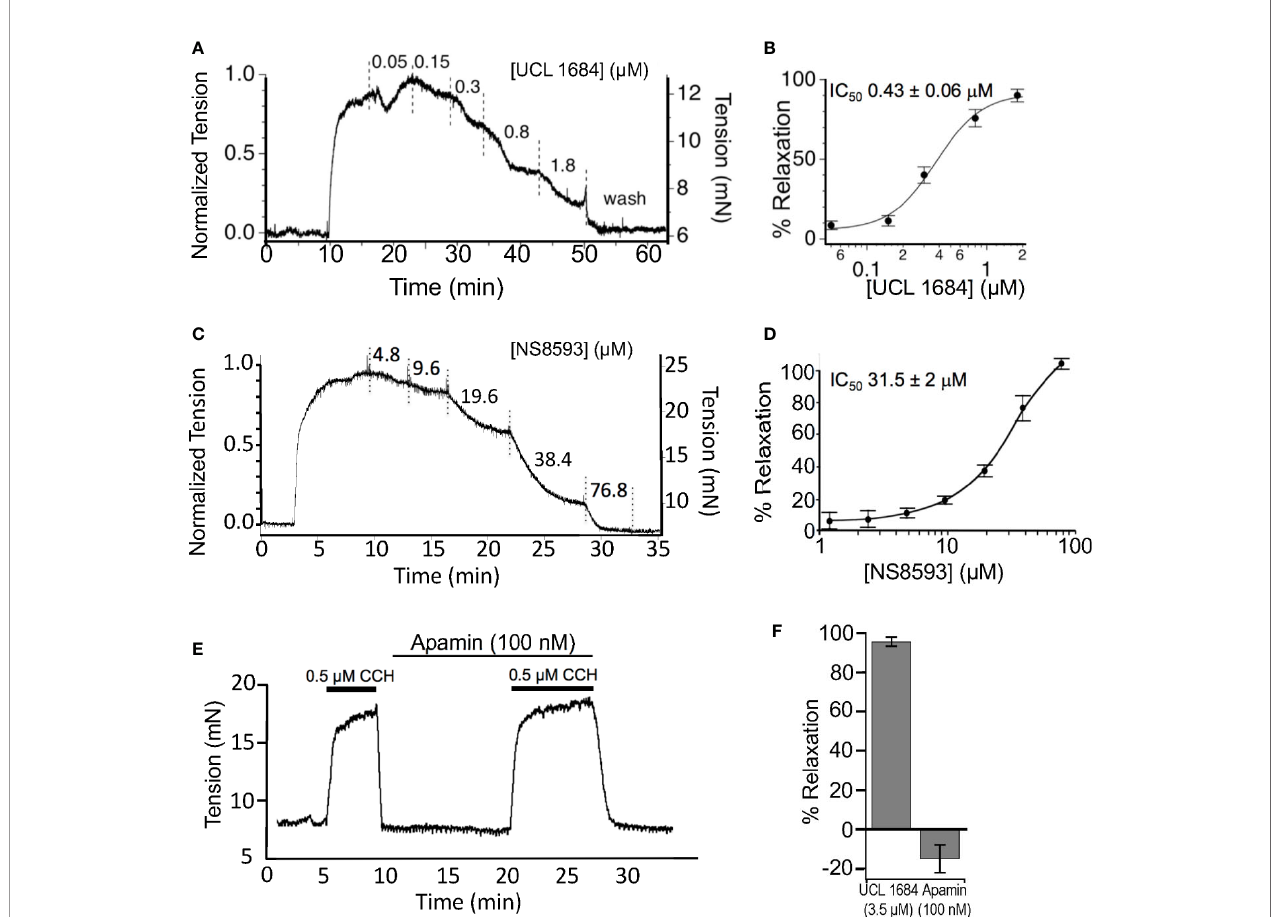
FIGURE 3 | UCL 1684 relaxes cholinergic evoked airway smooth muscle contractions. (A) Example isometric tension measurement of mouse trachea. The trachea was precontracted with 0.5 m M carbachol and cumulative increasing concentrations of UCL 1684 was applied to the bath at approximately 5-min intervals (or until tensions approached steady state levels). (B) Average response from N = 5 tracheas. The IC 50 was estimated to be 0.43 ± 0.06 m M, slope 1.7 ± 0.32 using a Hill function to the average response. (C) An example cumulative dose-relaxation response to increasing concentrations of NS8593. (D) Average response from N = 4 – 8 tracheas (depending on dose). The IC 50 was estimated to be 31.5 ± 2.0 m M, slope 1.3 ± 0.22 using a Hill function to the average response. (E) Example contraction in response to 0.5 m M carbachol, without and with wash-in of 100 nM of Apamin. (F) Summary comparisons of relaxation to 0.5 m M carbachol using single doses of 3.5 m M UCL 1684 (95.4 ± 2.4, N=6), and 100 nM Apamin ( − 15 ± 7,